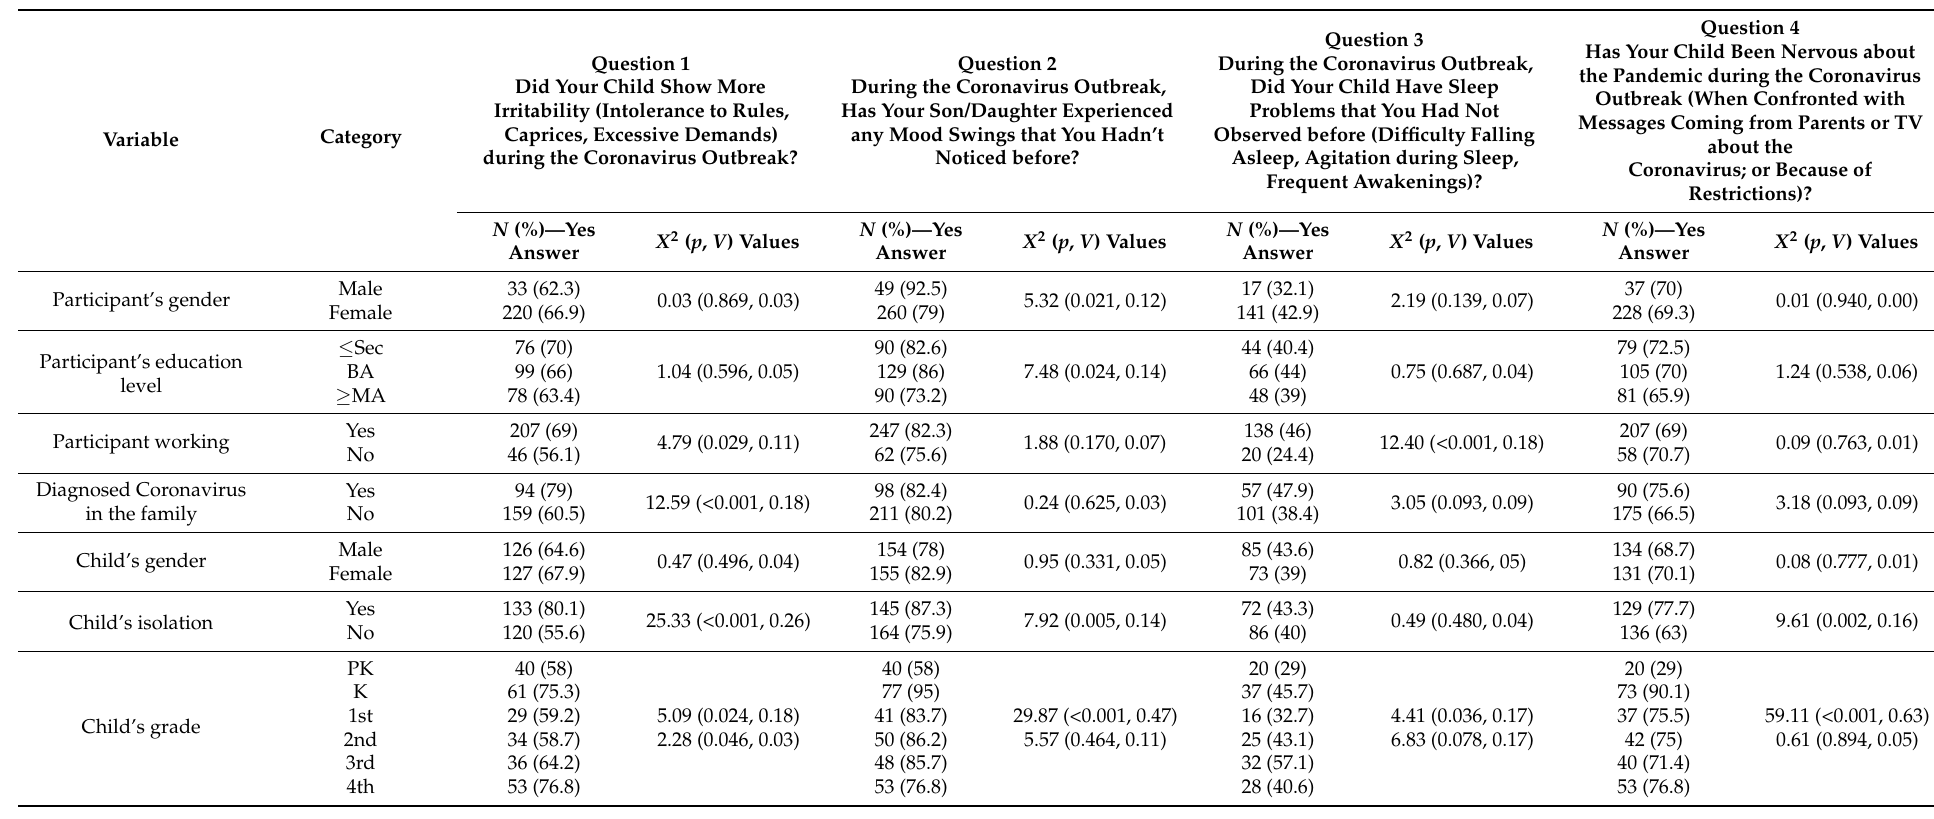
Table 4. Participants’ answers to the opposing behavior area questions by the study